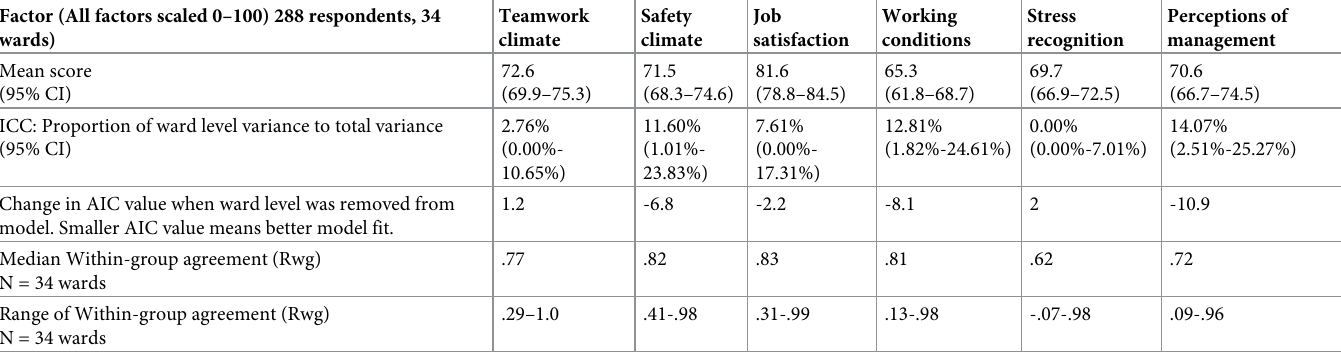
Table 3. Total variance of the six patient safety climate factor scores, partitioned by individual and ward (i.e., ward) level. Factor (All factors scaled 0–100) 288 respondents, 34 wards)